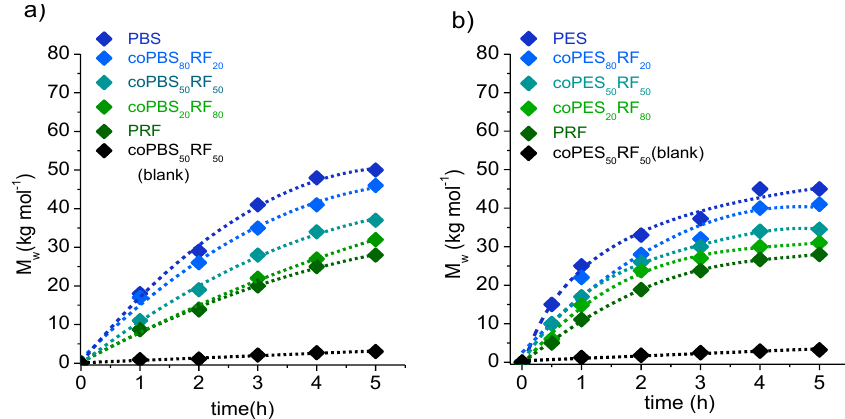
Figure 4. Evolution of M w along reaction time in the ROP of equimolar mixtures of c (RF) n and either c (BS) n ( a ) or c (ES) n ( b ) forthree different temperatures.